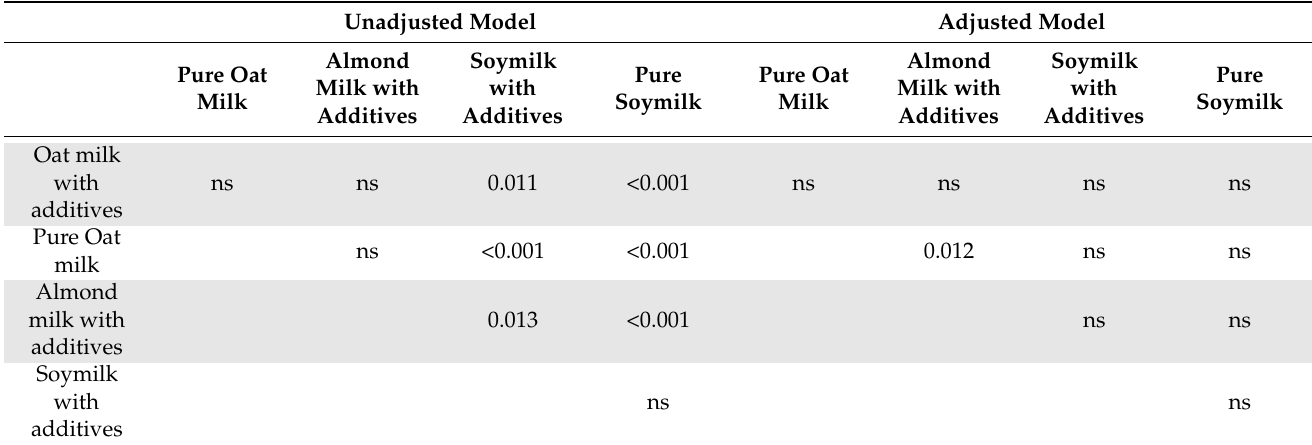
Table 6. Multiple comparisons between liquid types in terms of improvement in lutein liberation per gram of fat before and after adjustment for protein and